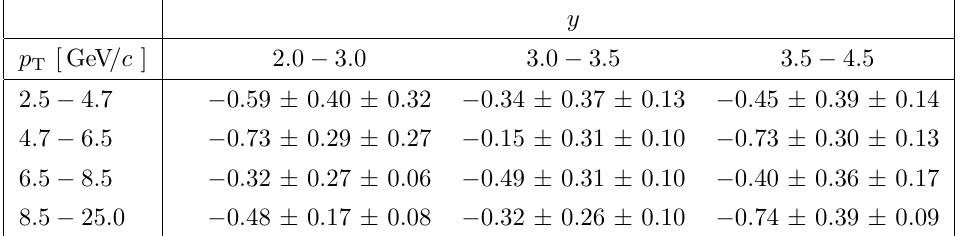
production asymmetry in percent, including, respectively, the statistical s kinematic bins using the s